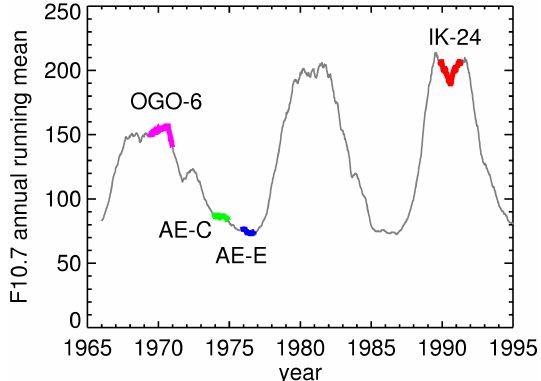
Fig. 2. Periods of data used from OGO-6, AE-C, AE-E, and IK-24 satellites with corresponding solar